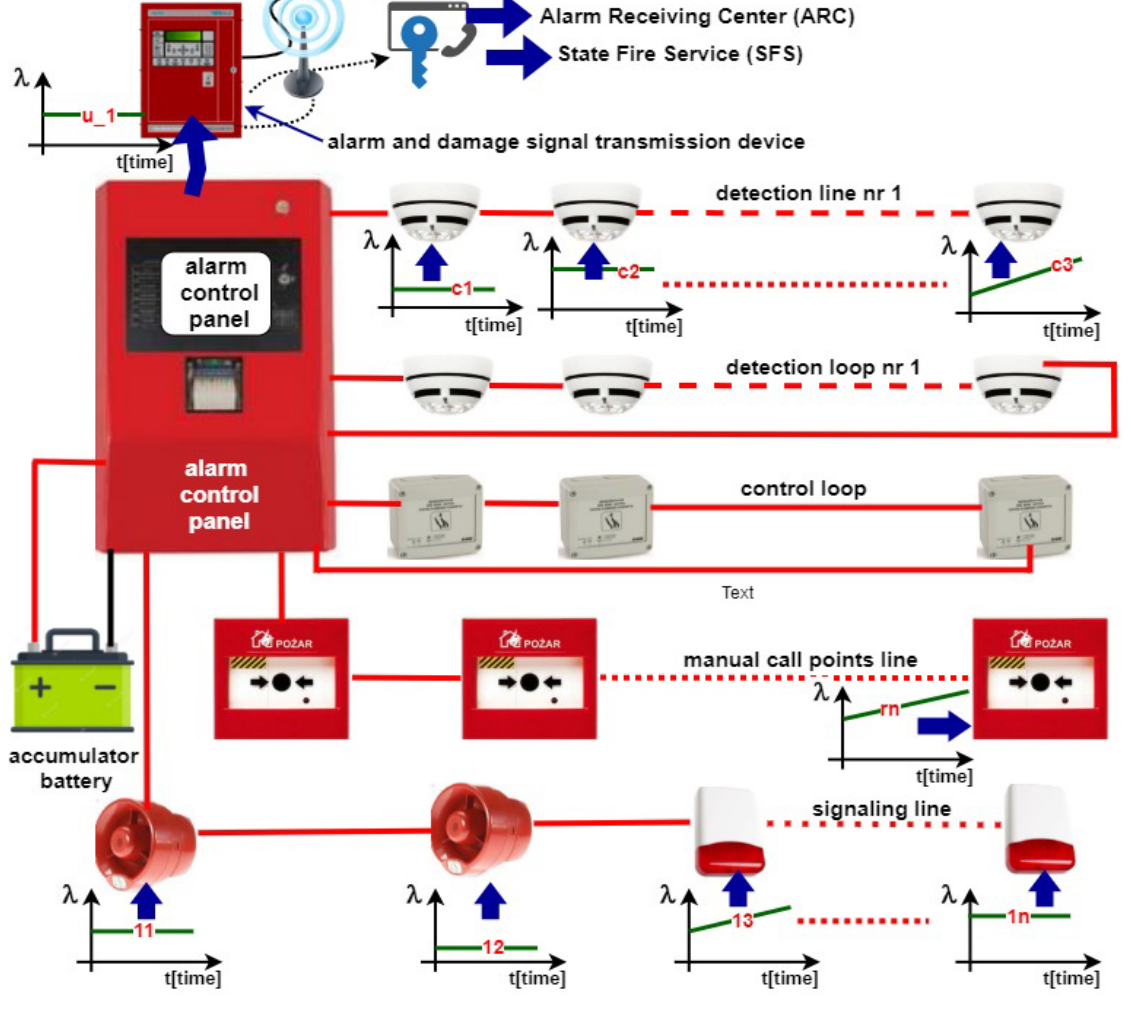
Figure 2. Diagram of a focused FAS, taking into account selected detection circuits and lines with sample damage intensities for individual elements and devices.